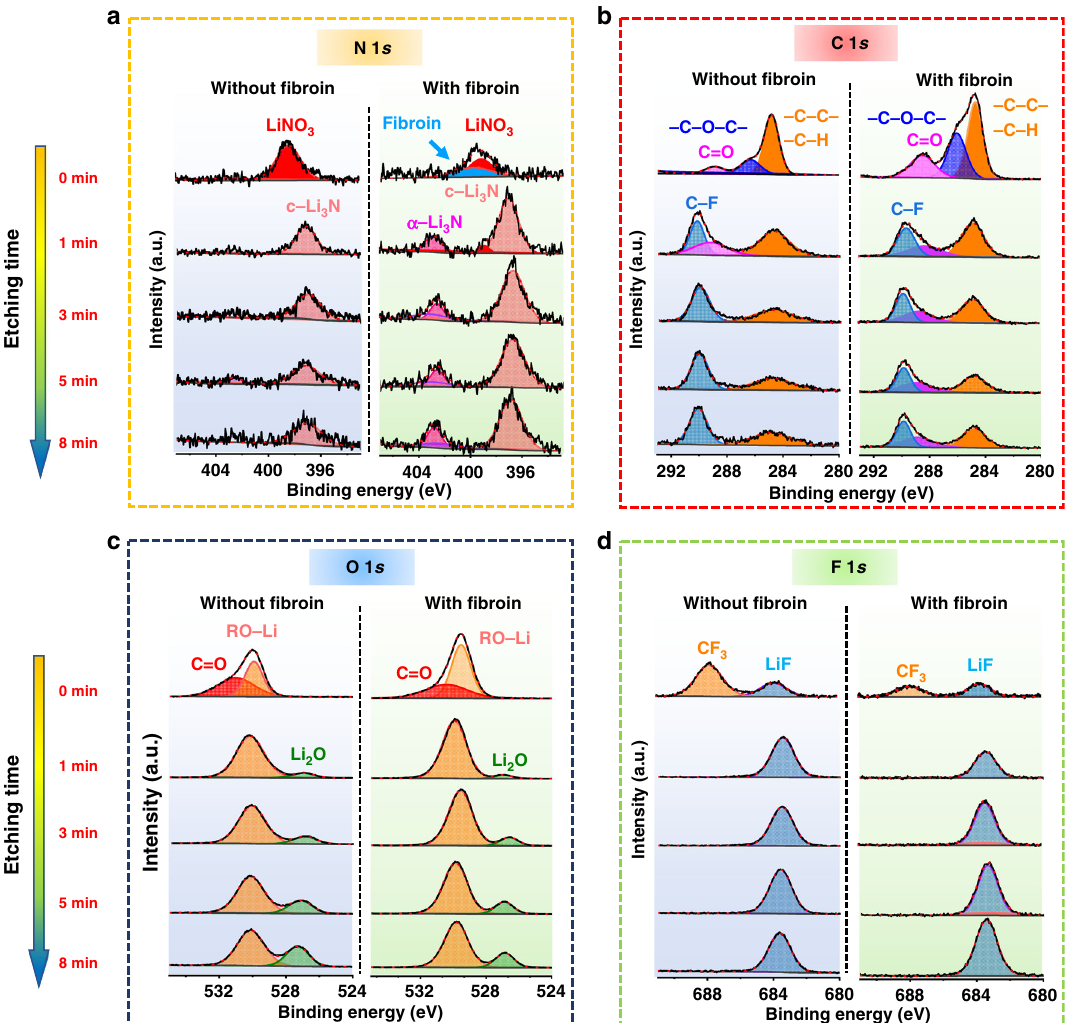
Fig. 3 X-ray photoelectron spectroscopy (XPS) characterization of SEI formed in ether-based electrolyte with and without fi broin. Li deposition was carried out at a current density of 1 mA cm − 2 and a capacity of 1 mAh cm − 2 on Cu foil for 10 cycles. a N1s spectra, b C1s spectra, c O1s spectra, and d F1s